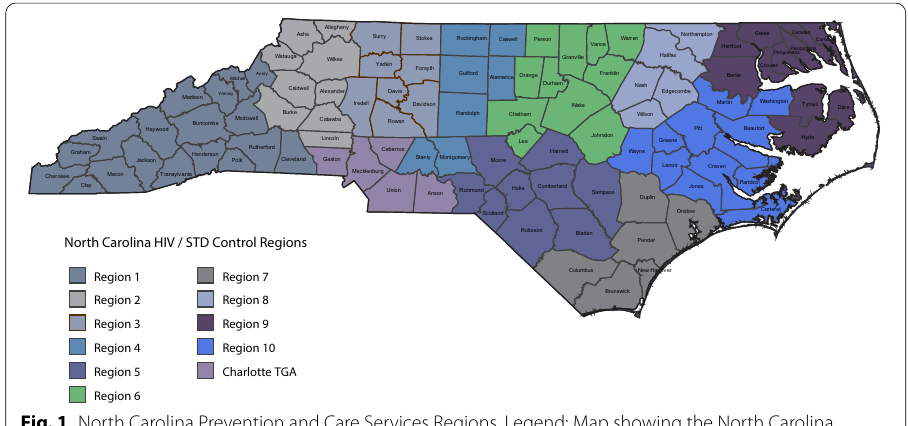
Fig. 1 North Carolina Prevention and Care Services Regions. Legend: Map showing the North Carolina Regions for Prevention and Care Services. We abstracted HIV and syphilis cases diagnosed during 2012–2013 from among residents of the 11 contiguous counties of Region 6 (green